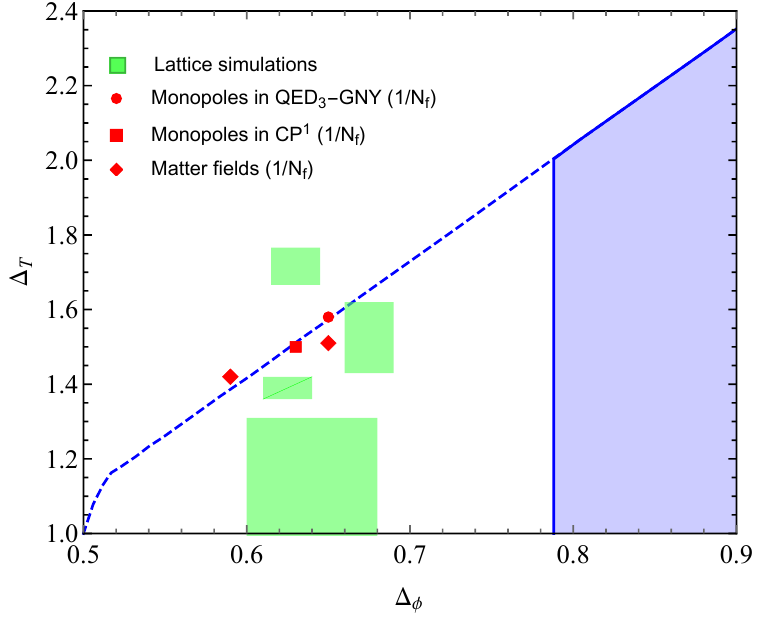
Figure 2 . Dashed blue line: upper bound on the scaling dimension ∆ T . Blue shadowed region: bootstrap allowed region of (∆ φ , ∆ T ) with a gap assumption ∆ Sig > 3